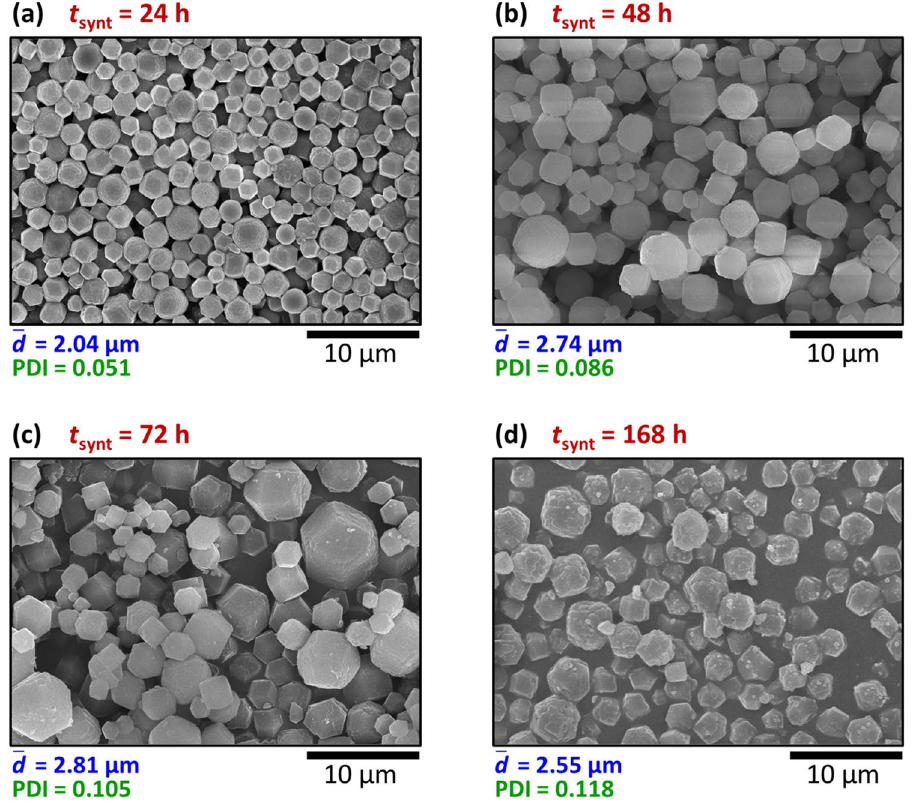
Figure 4. Synthesis time ( t synt ) dependence of the particle size in the middle of the precipitate zone in the reaction–diffusion synthesis represented in SEM images ( a – d ). The boundary concentrations were [Zn 2+ ] 0 = 2.5 mM and [2-MeIm] 0 = 25 mM in every case. The average particle size (cid:31) d (cid:30) and the polydispersity index (PDI) are given below the SEM